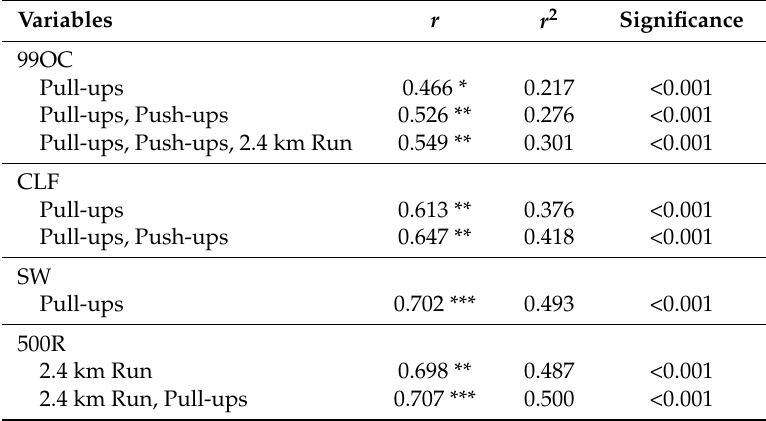
Table 3. Stepwise linear regression analysis between the WSTB and PT500 in law enforcement recruits ( n =